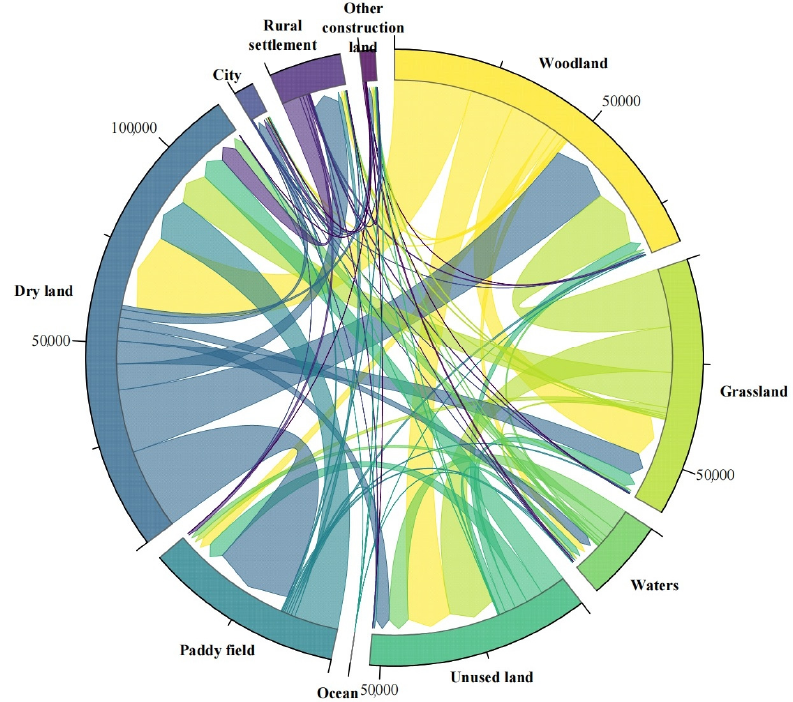
Figure 3. Land type transfer table.